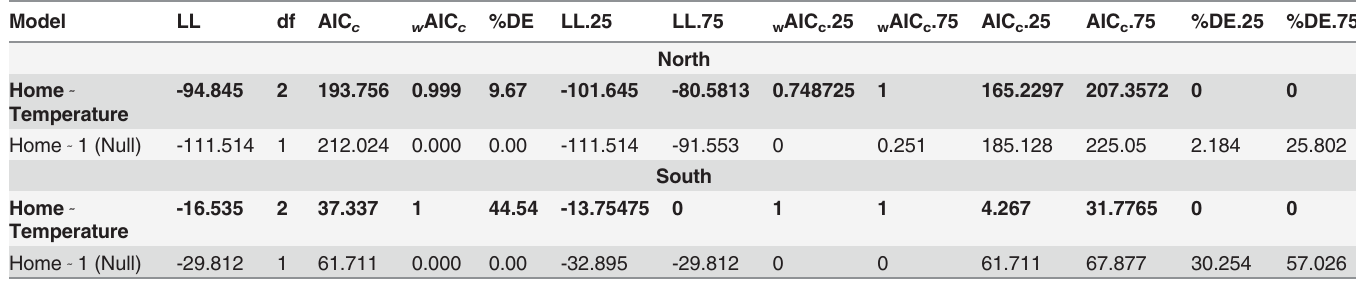
Table 3. Ranked Generalised Linear Models with bootstrap sampling of the probability of a shark being in a 25% utilisation distribution explained by sea surface temperature (Temperature) at the north and south coast separately.